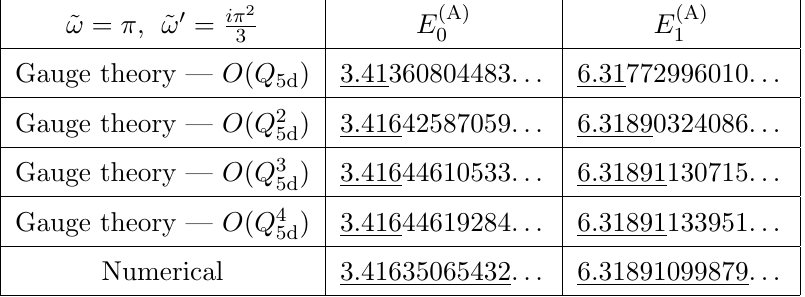
p p 7, ~ y = 2 obtained from